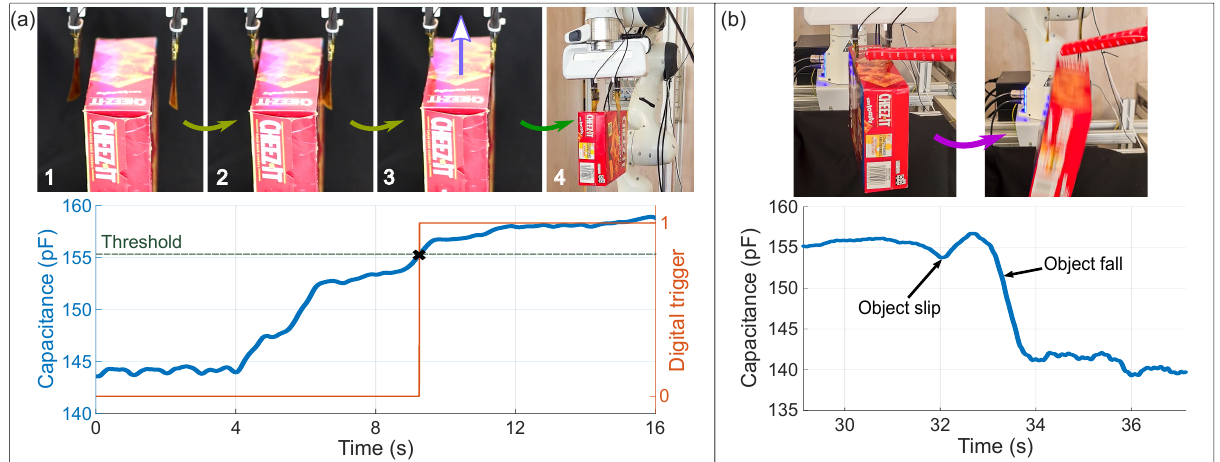
Figure 10. Capacitance variation during manipulation of a cardboard box grasped by two electroad- hesive pads mounted on a parallel gripper of a robotic arm. ( a ) Grasping. The upper part of the figure shows images of the steps performed by the robot, whereas the lower part plots the capacitance variation in time and the trigger that signals successful pad adhesion. The steps can be described as follows: 1. Both pads are distanced from the box, there is no contact established and the capacitance stays constant. 2. One of the pads establishes first contact and gradually adheres to the surface of the box, thus causing the first rise in capacitance. 3. The second pad establishes contact and gradually adheres to the surface of the box, thus causing the second increase in capacitance. An imposed capacitance threshold of sufficient adhesion is surpassed, which causes a trigger to be sent to the robot. The robot stops the gripper and starts pulling the object up. 4. The object is being pulled up, there are no prominent capacitance variations. ( b ) Induced falling. The upper part shows images of the box being hit twice, first time ( upper left ) causing only slipping and wobbling, second time ( upper right ) causing the box to completely detach and fall. The lower part shows the corresponding capacitance